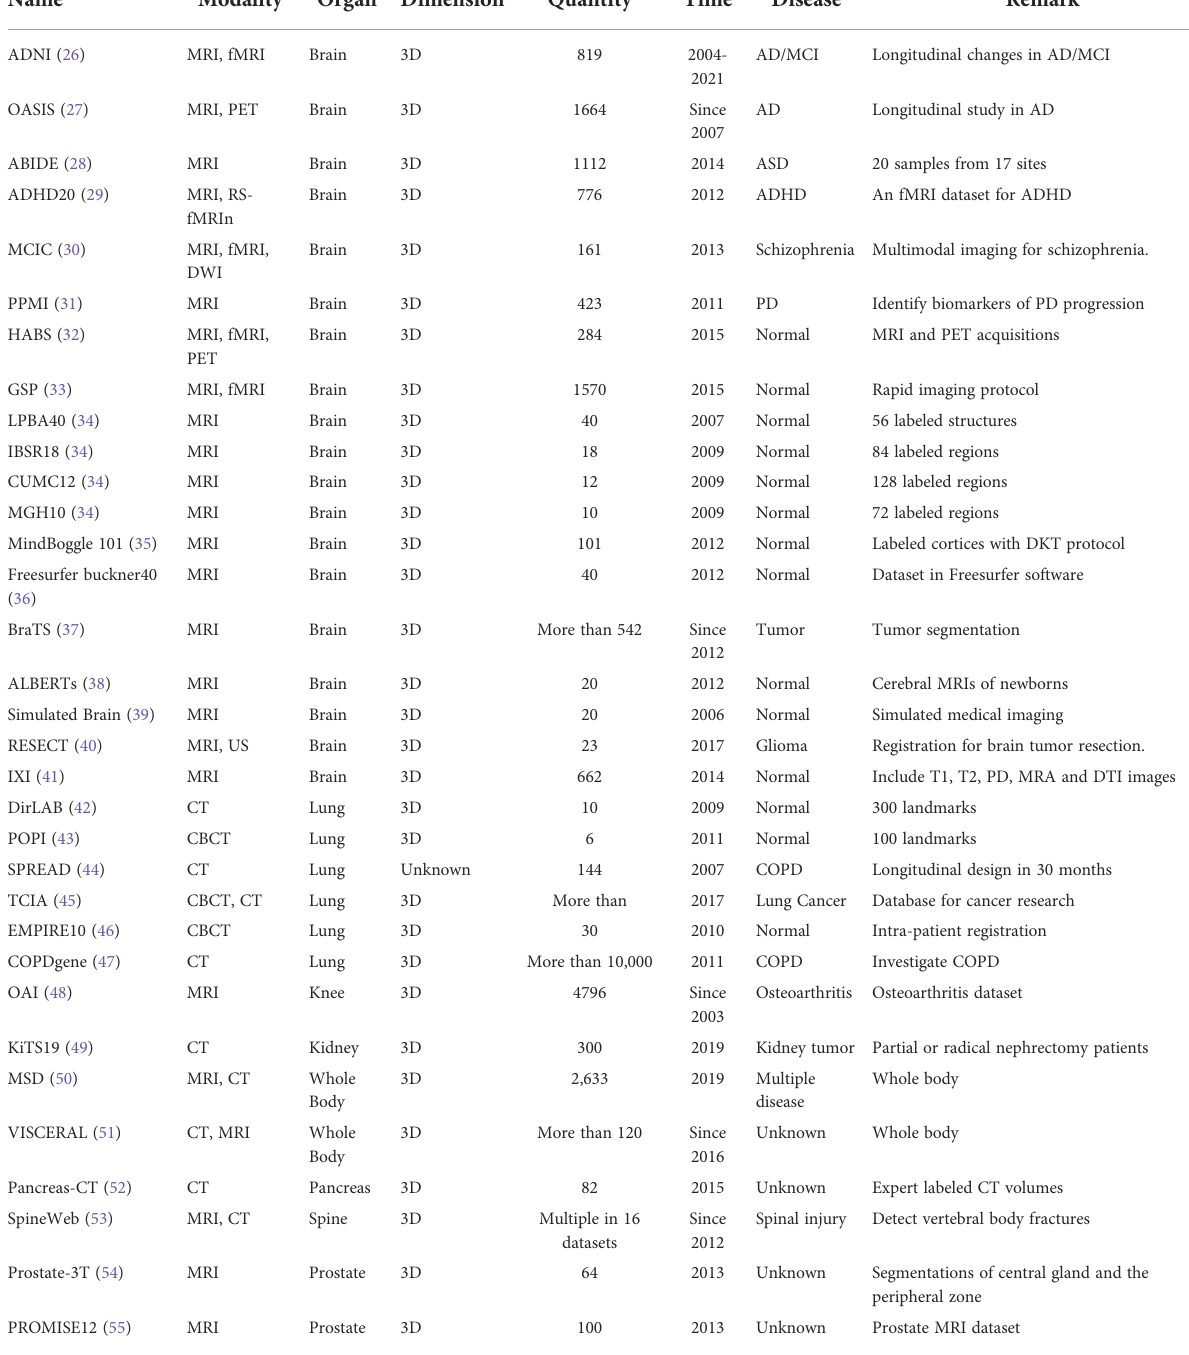
TABLE 1 Public dataset for benchmarking medical image